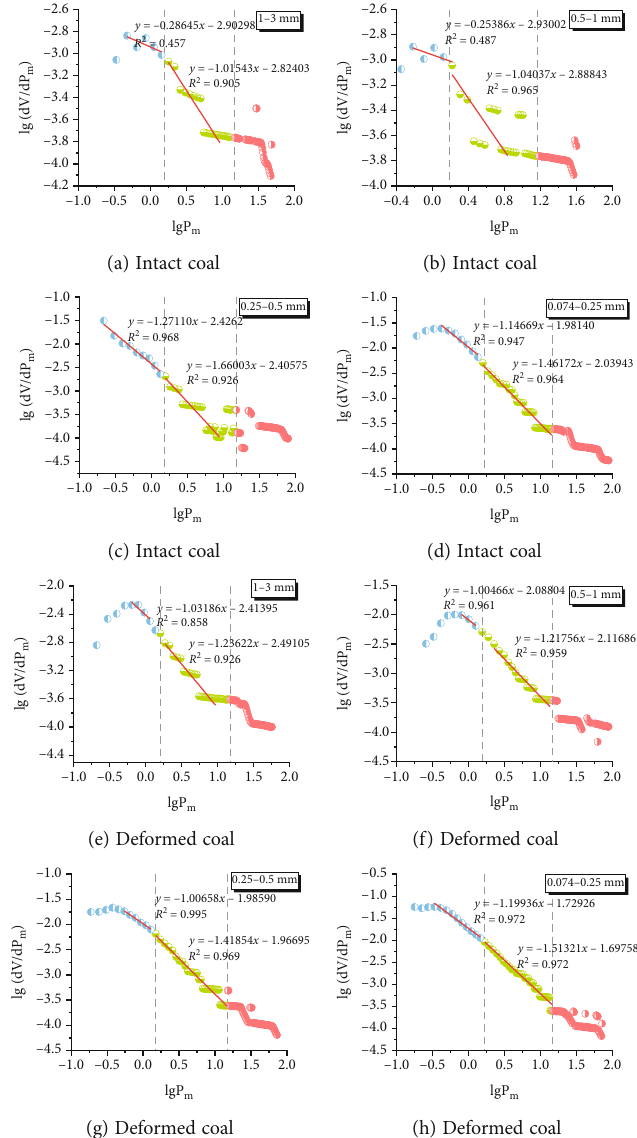
Figure 8: Fractal dimensions of macropores and